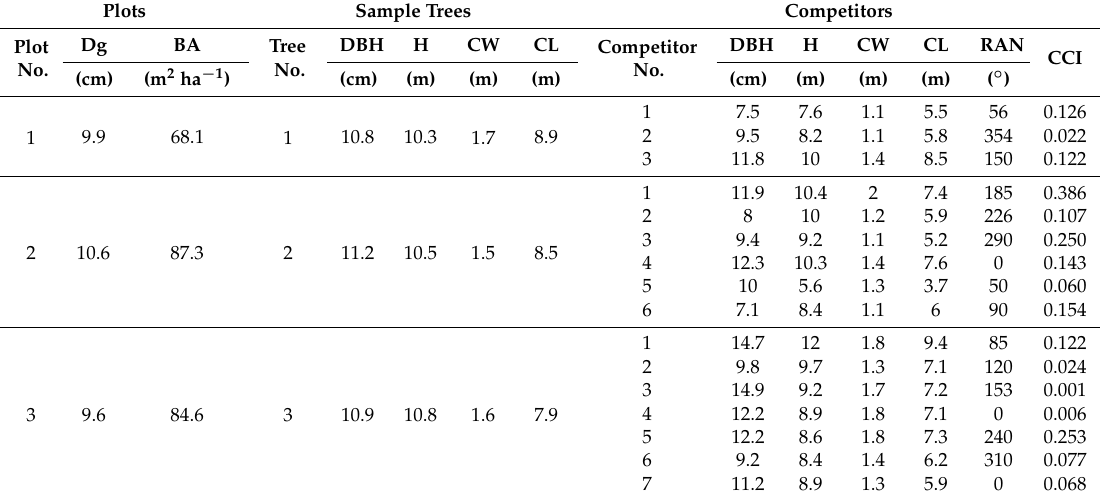
Table 1. Attributes of the plots, sample trees, and corresponding competitors for the L. olgensis plantation. Plots Sample Trees Competitors Dg Tree Plot No.